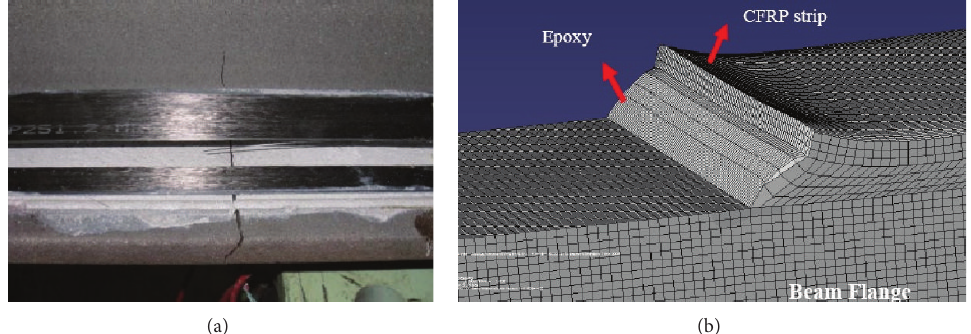
Figure 15: (a) Debonded strip rupture, (b) end debonding model using FEA